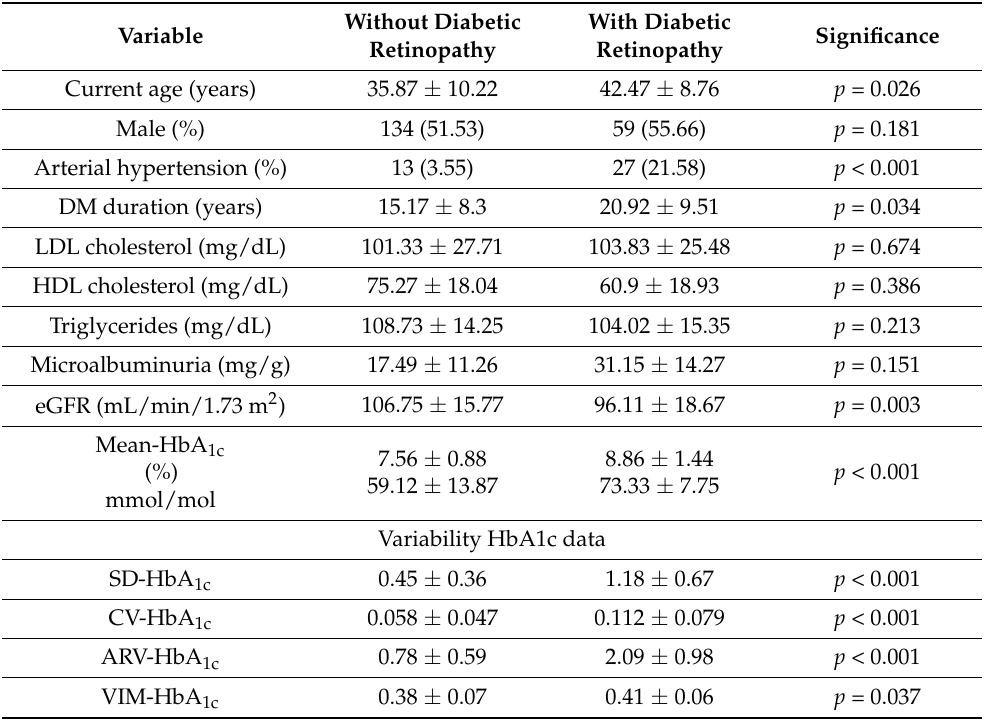
Table 1. Univariate study of diabetic